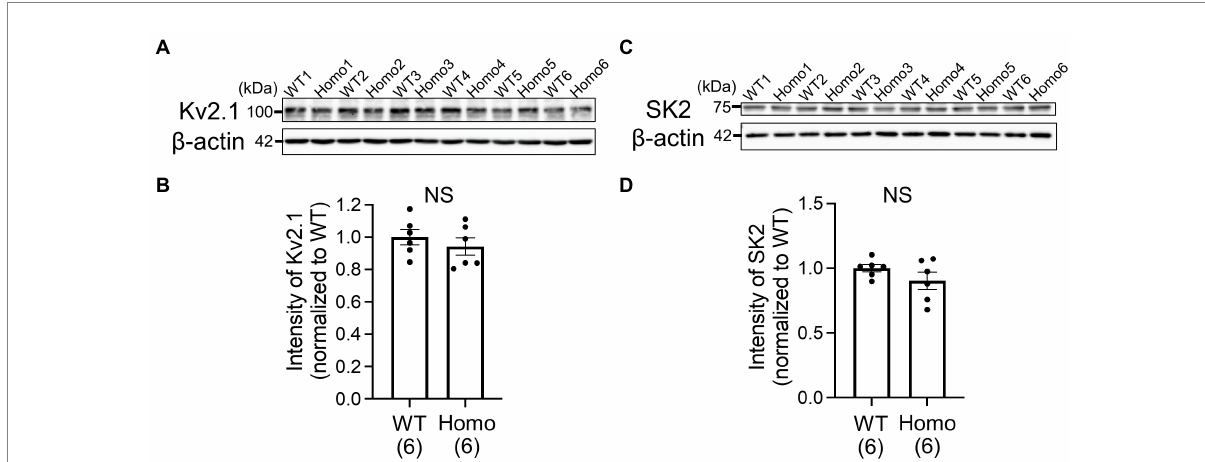
FIGURE 6 Comparison of protein expression levels of Kv2.1 and SK2 channels in the neocortex of WT and TauT Homo KO mice by Western blot analysis. (A) Immunoblots indicating the levels of Kv2.1 and β -actin in individual neocortices of WT and Homo KO mice. Lysates from six WT (WT1-WT6) and six Homo (Homo1-Homo6) mice were loaded onto the same polyacrylamide gel and blotted onto the same membrane. (B) Statistical comparison of Kv2.1 levels between WT and Homo mice. The ratio of Kv2.1 band intensity to β -actin band intensity in each lane was normalized to the mean of the ratios in the six WT lanes. Normalized ratios are plotted for each group of WT and Homo, with the height of the bar representing the mean in each group. Error bars indicate SEMs. The numbers in brackets indicate the numbers of mice analyzed. p = 0.394 by Mann–Whitney U test. NS, not significant. (C) Immunoblots for SK2 made in the same way as in (A) . (D) Comparison of SK2 levels. The ratio of SK2 intensity to β -actin intensity in each lane was normalized to the mean of the ratios in the six WT lanes. p = 0.394 by Mann–Whitney U